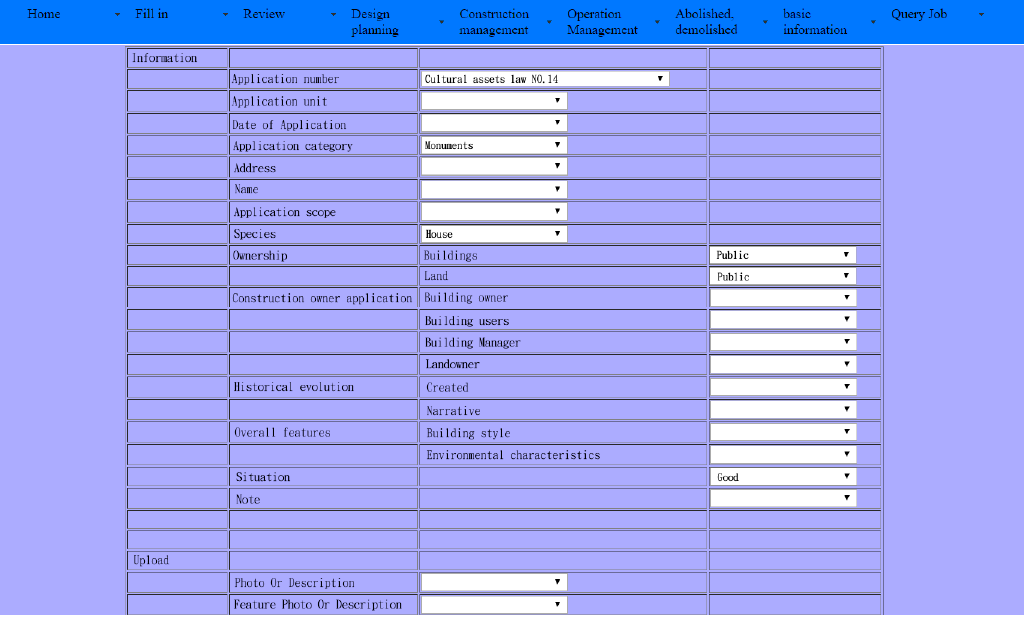
Figure 9. Application page on the management interface. Arts 2018 , 7 , x FOR PEER REVIEW